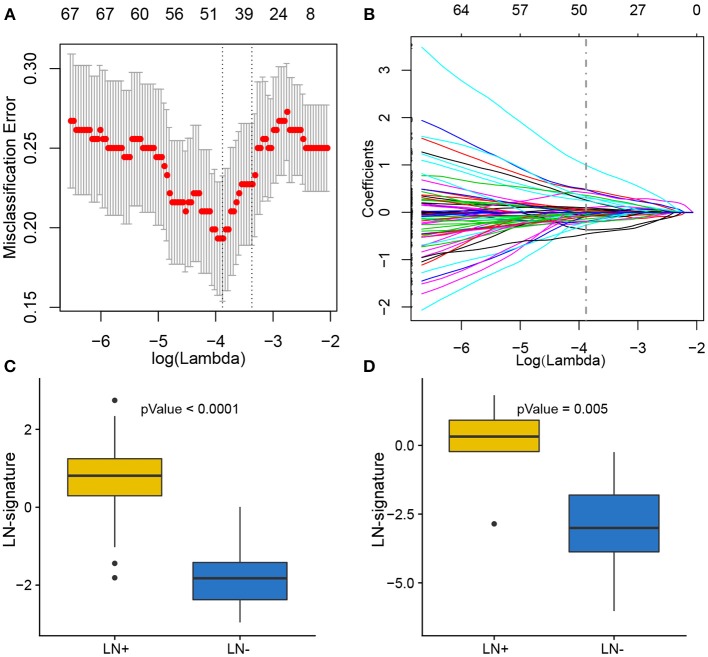
Feature selection using LASSO binary logistic regression model. (A) Tuning parameter λ (lambda) selection in the LASSO model used 10-fold cross-validation by minimum criteria. The misclassification error was plotted vs. log(λ). Dotted vertical lines were drawn at the optimal values by using the minimum criteria. A λ of 0.021 with log(λ) of −3.881 was chosen according to 10-fold cross-validation. (B) LASSO coefficient profiles of the 180 genes. A coefficient profile plot was produced against the log(λ) sequence. A vertical line was drawn at the value selecting by 10-fold cross-validation, where the optimal λ resulted in 48 non-zero coefficients. Distribution of calculated LNM signature vs. LN metastasis status for both training set and testing set were plotted by boxplot in (C) and (D), respectively.